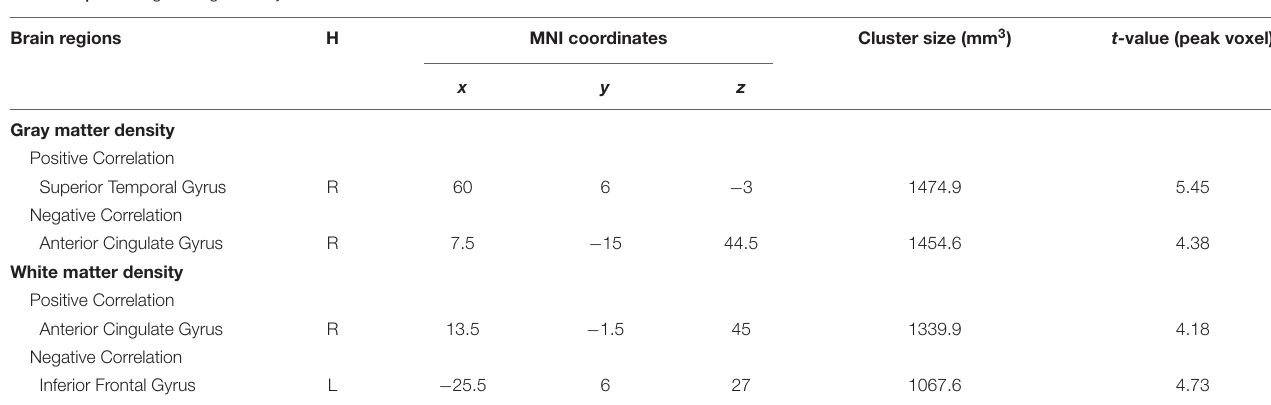
TABLE 2 | Brain regions significantly correlated with the score of